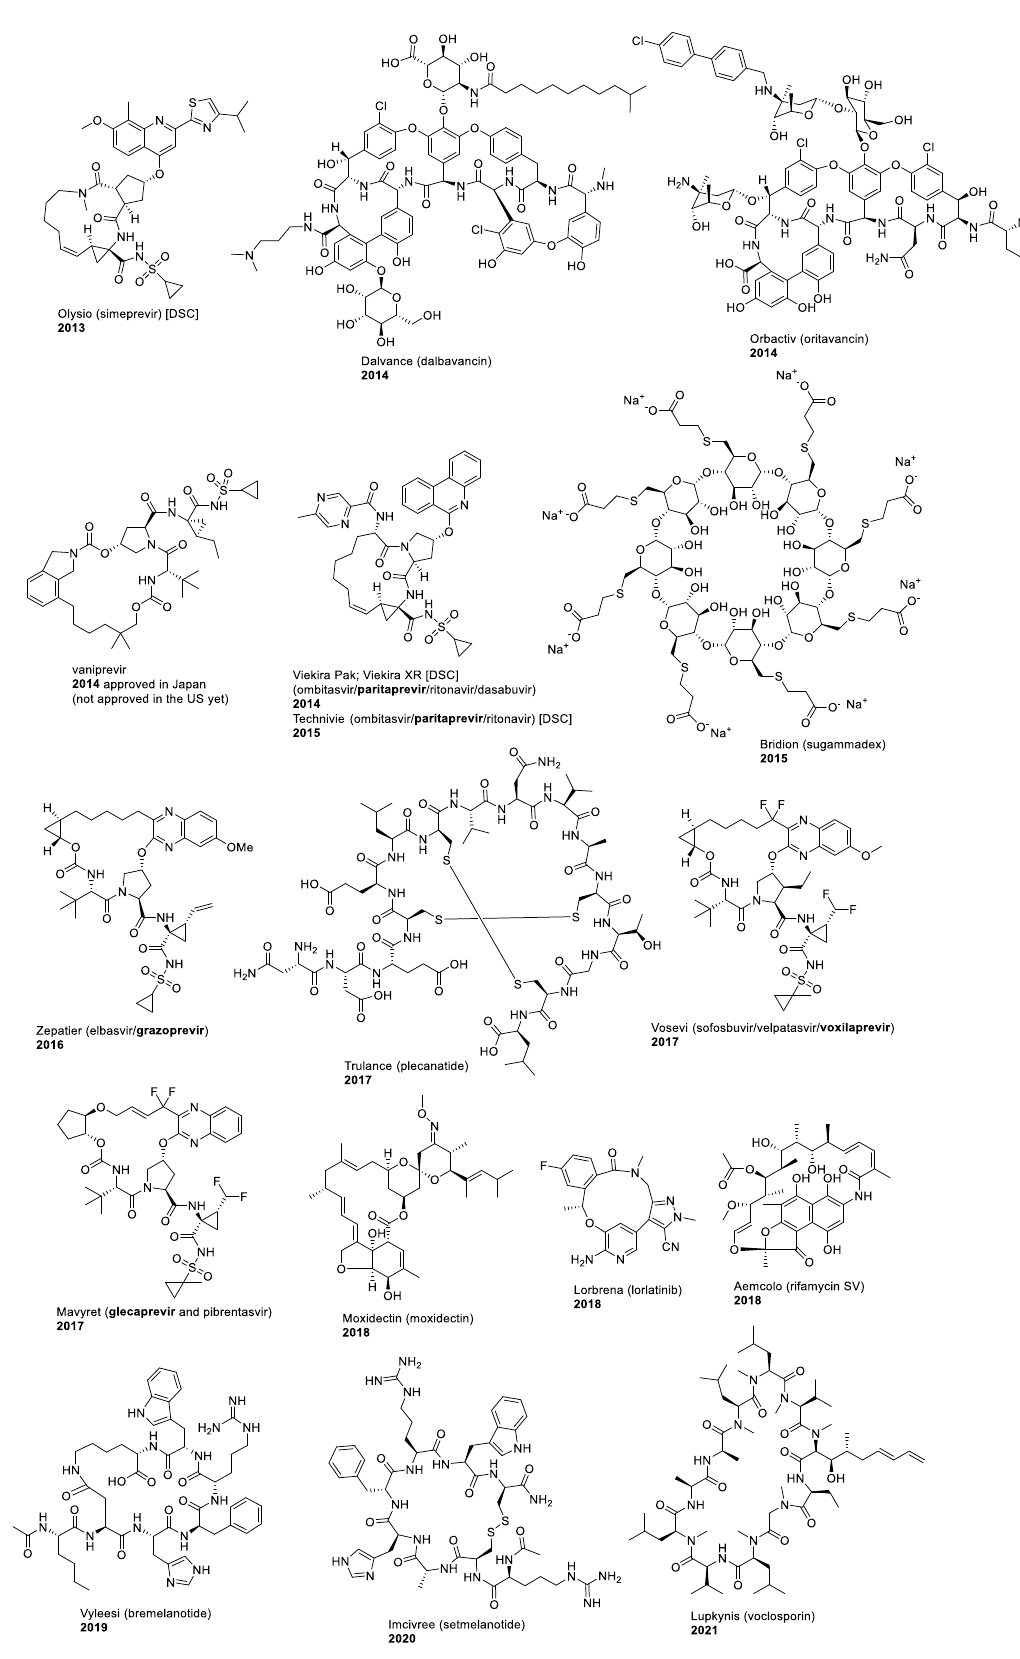
Figure 1. Macrocyclic drugs approved by the US FDA since 2014.